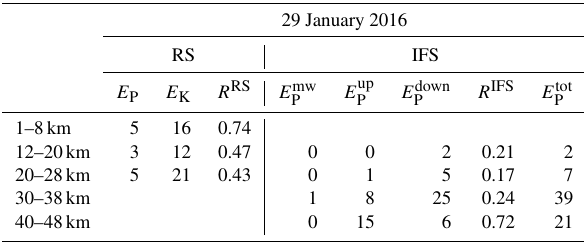
Table 2. As for Table 1 for the 29 January 2016 10:42UTC sound- ing and IFS temperature perturbation on 29 January